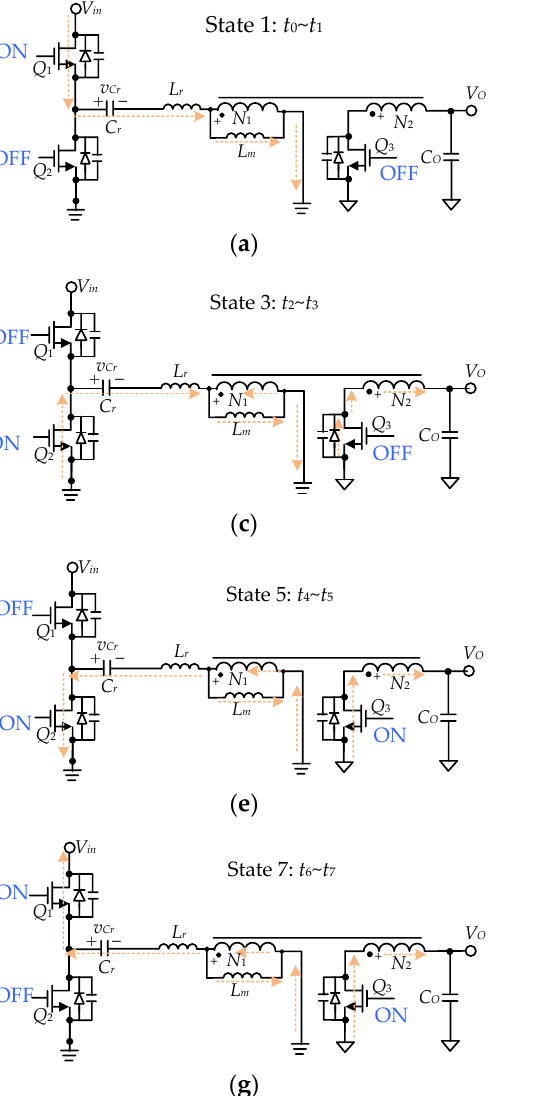
Figure 3. Operation waveforms of the proposed circuit.